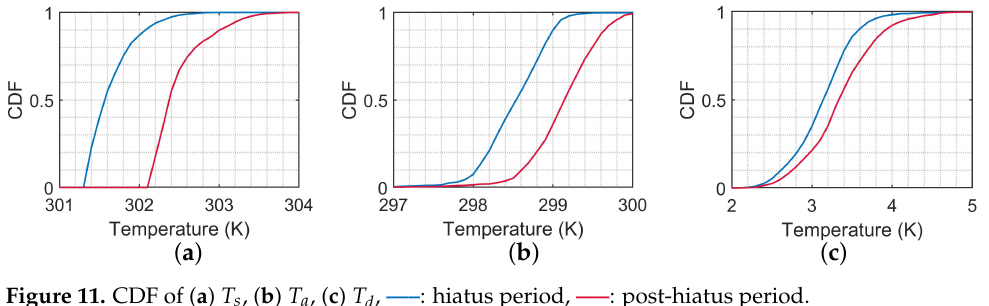
Figure 11. CDF of ( a ) T s , ( b ) T a , ( c ) T d , —– : hiatus period, —– : post-hiatus period.